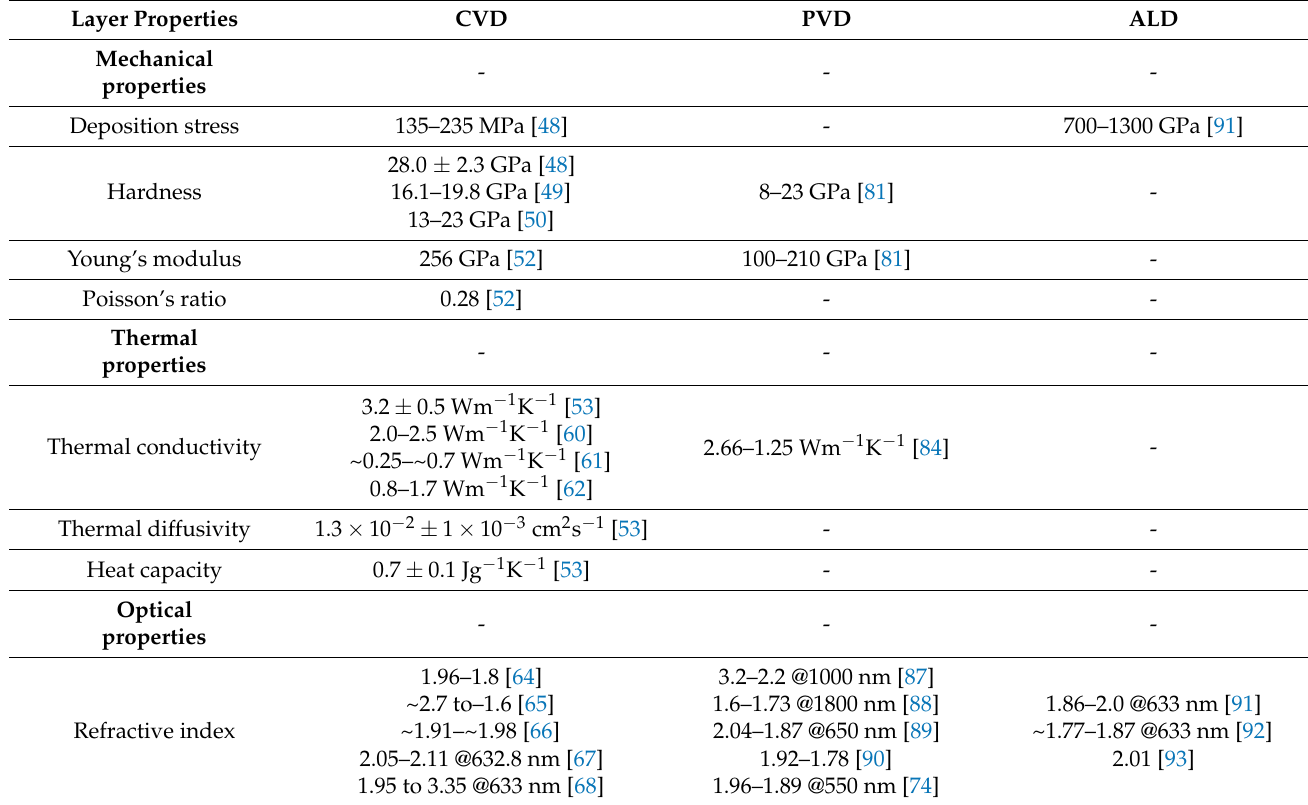
Table 2. Comparison of mechanical, thermal, and optical properties of CVD and PVD SiNx thin